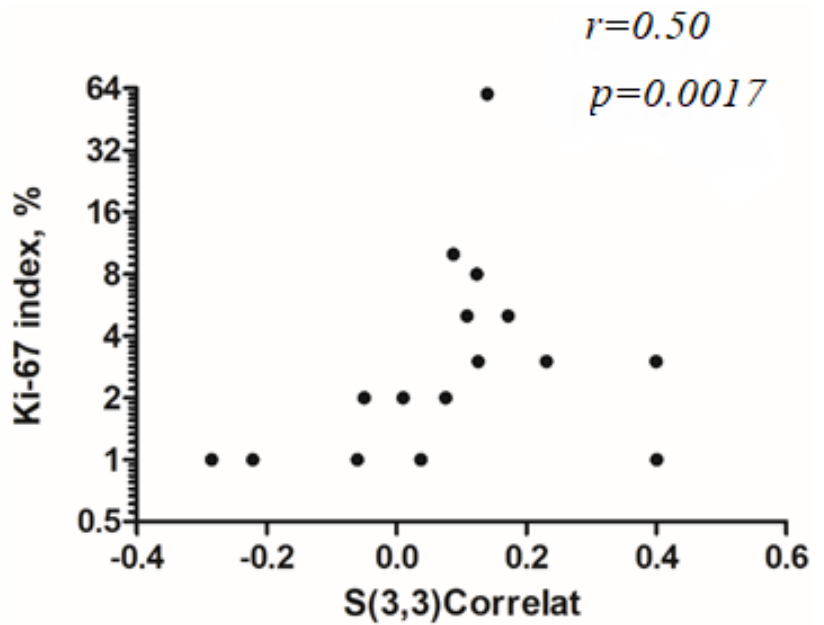
Figure 3. Spearman’s correlation analysis between Ki-67 index and “S(3,3)Correlat” ( r = 0.50, p = 0.017). The Ki-67 axis is displayed on a log 2 scale.